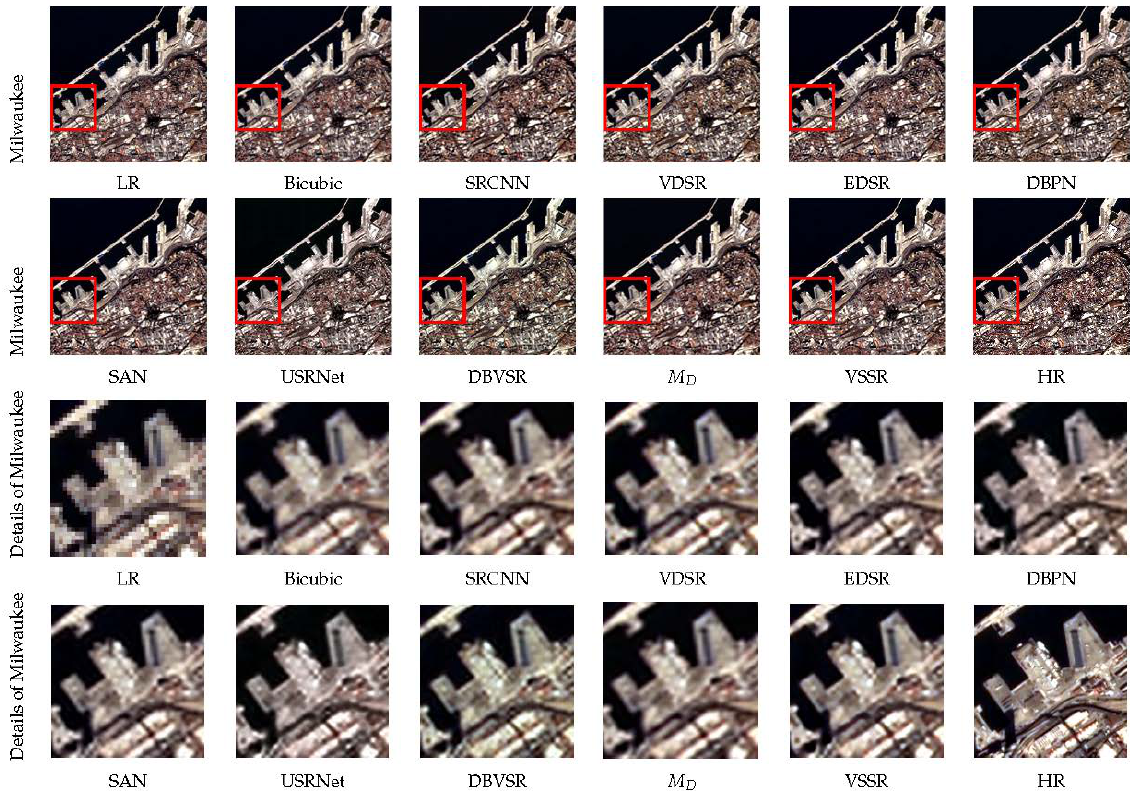
Figure 13. Reconstruction results on the third frame of Milwaukee (OVS-1 data) by the scale factor of ×